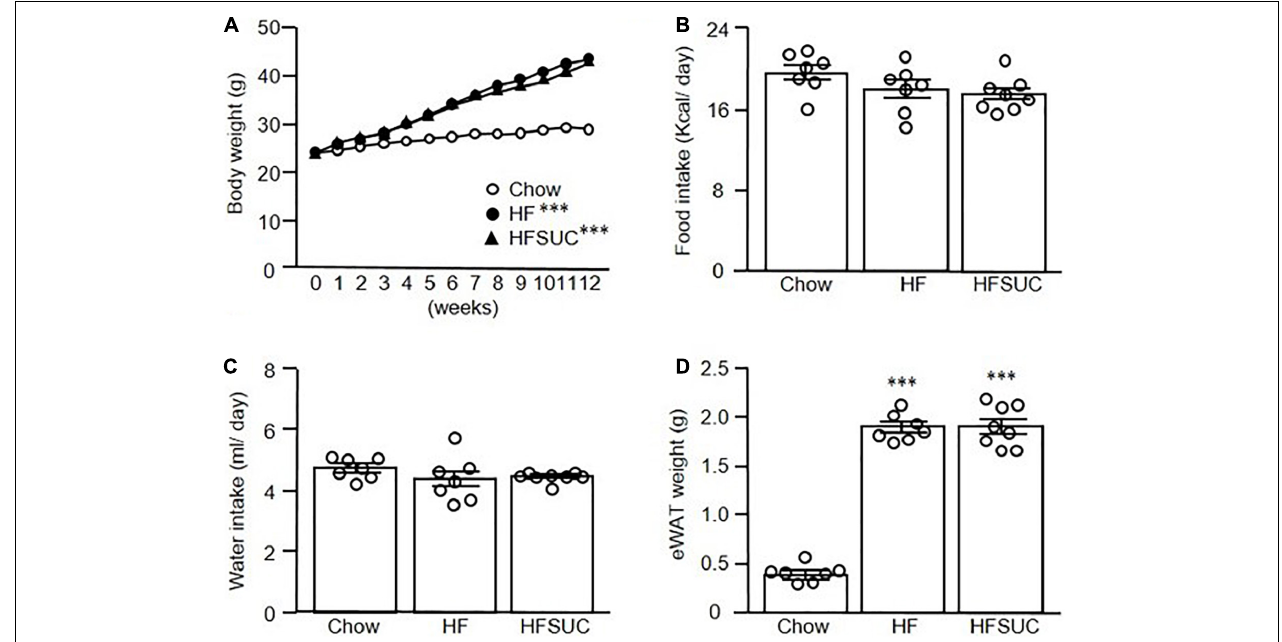
FIGURE 1 | Supplemen of sucralose in high-fat diet showed no significant effects on the body weight of mice. Eight-week-old C57BL/6 mice were fed with a chow diet (Chow), high-fat diet (HFD), or HFD supplemented with sucralose (HFSUC) for 12 weeks, and the body weight (A) , food intake (B) , and water intake (C) were measured using metabolic cages. At the end of the experiments, each group of the mice was sacrificed and the epididymal fat pads (eWAT) were removed and weighed (D) . Data are mean ± SEM ( n = 7–8 for each group of the mice) ∗∗∗ p < 0.001 as compared with the Chow group.